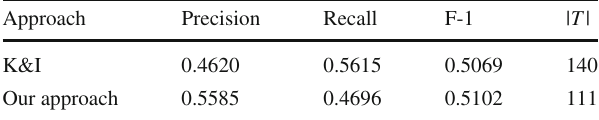
Table 10 Results of comparing the RDF triple extractors Approach